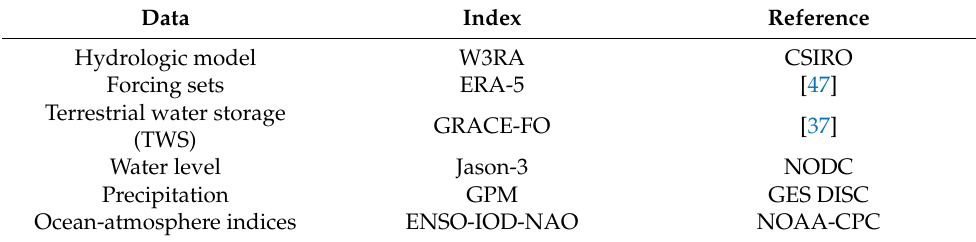
Table 1. List of the datasets used for the